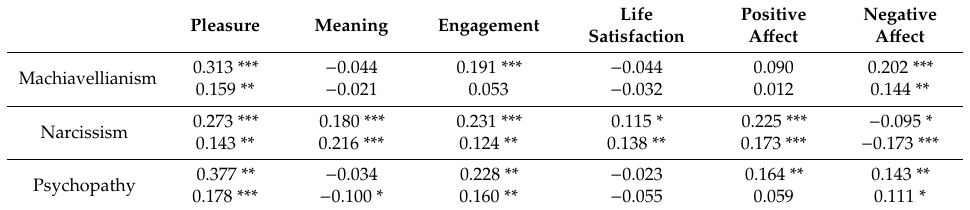
Table 1. Zero-order and partial correlations among the variables of